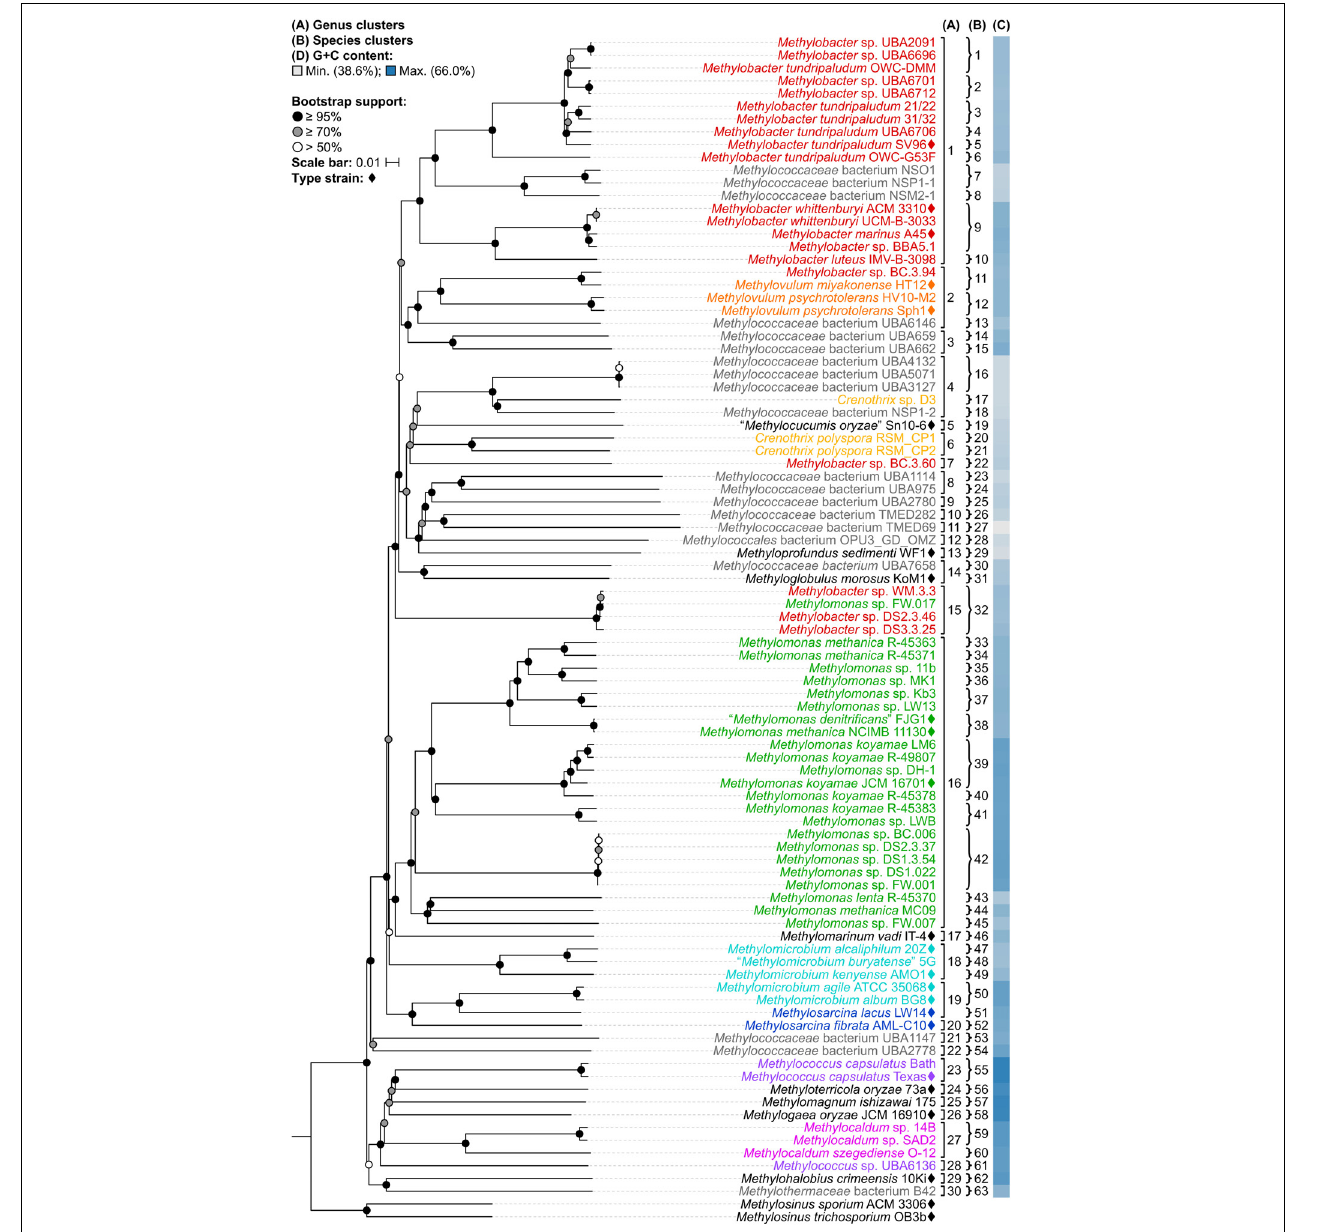
FIGURE 2 | The Methylococcales phylogenomic tree inferred with GBDP. The tree was inferred with FastME from GBDP distances calculated from the genome sequences restricted to coding regions. Methylosinus was chosen as outgroup. Pseudo-bootstrap support is indicated on the nodes as black ( ≥ 95%), gray ( ≥ 70%), or white ( > 50%) circles. The branches are scaled in terms of log-transformed intergenomic distances (GBDP formula d 5 ). Genera with at least two members are colored; genera with single members (and outgroup) are black; genomes with no genus designation are gray. Diamonds indicate type strains. Inferred clusters are for (A) genus, denoted by numbers and brackets and (B) species, denoted by numbers and braces. (C) Percent G+C content of genome